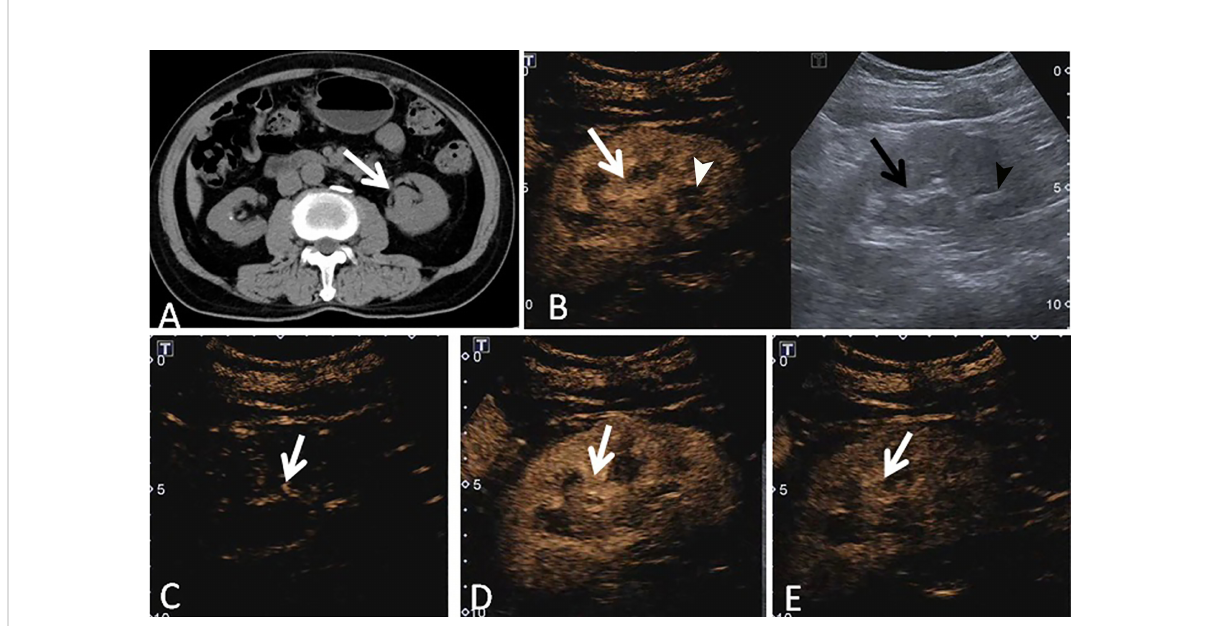
FIGURE 3 A 73-year-old man had a UCRP in the left kidney with the size of 3.4 × 1.9 cm. (A) Non-enhanced CT scan showed that there may be blood clots in the renal pelvis (white arrow). (B) According to the position displayed on CT, the simultaneous display mode of CUS (right) and CEUS (left) was performed. No obvious lesion (black arrow) was detected on CUS, but it showed a slight separation of the renal pelvis and a stone (black arrowhead) in the lower part of the renal pelvis. On CEUS, a lesion with enhancement was observed (white arrow), and the stone showed no enhancement (white arrowhead). (C) The contrast agent entered the lesion more slowly than that of the adjacent renal cortex (white arrow). (D) The tumor showed heterogeneous enhancement, and the enhancement intensity of the tumor (white arrow) was similar to that of the adjacent renal cortex. (E) The contrast agent discharged from the mass quickly, and the tumor (white arrow) showed a fast-out pattern compared to the renal